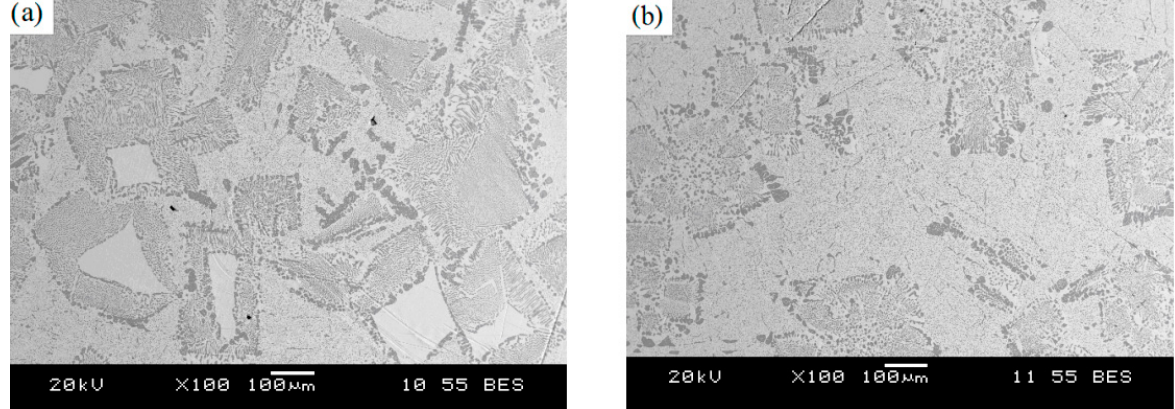
Figure 16. Microstructure of Bi–18Sn–32Pb alloy ( a ) initial and ( b ) with EMP treatment [43].